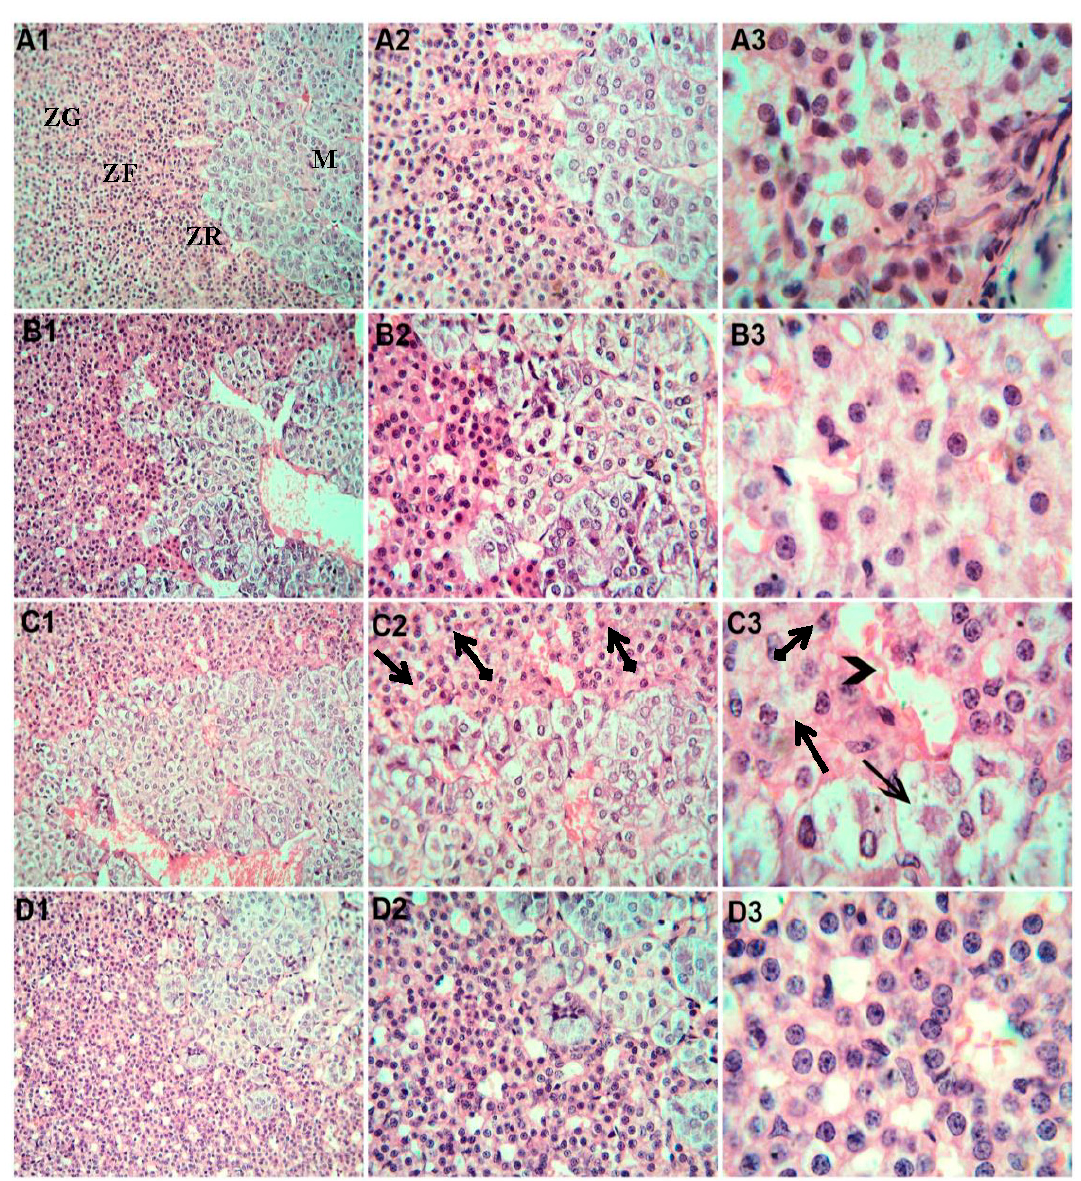
Figure 4. Representative adrenal gland sections photomicrographs. ( A1 , A2 , A3 ) Control rats demon- strating the normal structure of the zona glomerulosa (ZG), zona fasciculata (ZF), zona reticularis (ZR), and medulla (M). ( B1 , B2 , B3 ). Rats that received Mg and showing normal histological architecture and arrangement of cells within the adrenal cortex and medulla. ( C1 , C2 , C3 ) Rats exposed to SiNPs showing disorganized cell cords interspersed with distended blood sinusoids (arrow heads) and abnormal cortical cells, which show vacuolated cytoplasm (arrows) and pyknotic nuclei (tailed arrows). H&E. ( A1 , B1 , C1 , D1 ) ×20 magni fi cation. ( A2 , B2 , C2 , D2 ) ×40 magni fi cation. ( A3 , B3 , C3 , D3 ) ×100 magni fi cation.